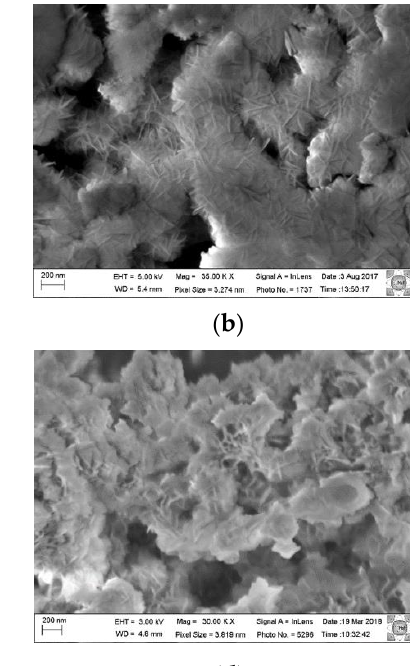
Figure 3. Micrographs of Al,Mg-LDH samples: ( a ) and ( b ) as-synthesized Al,Mg-LDH sample and ( c ) and ( d ) calcined sample under O 2 flow and rehydrated with H 2 O vapor.